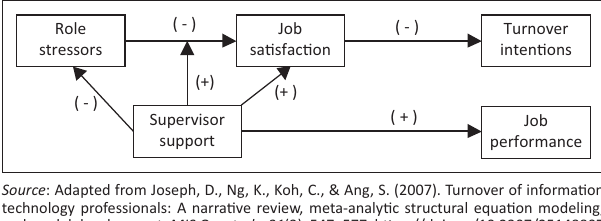
FIGURE 1: Hypothesised model of the relationships between role stressors, supervisor support, job satisfaction, job performance and turnover intention in information